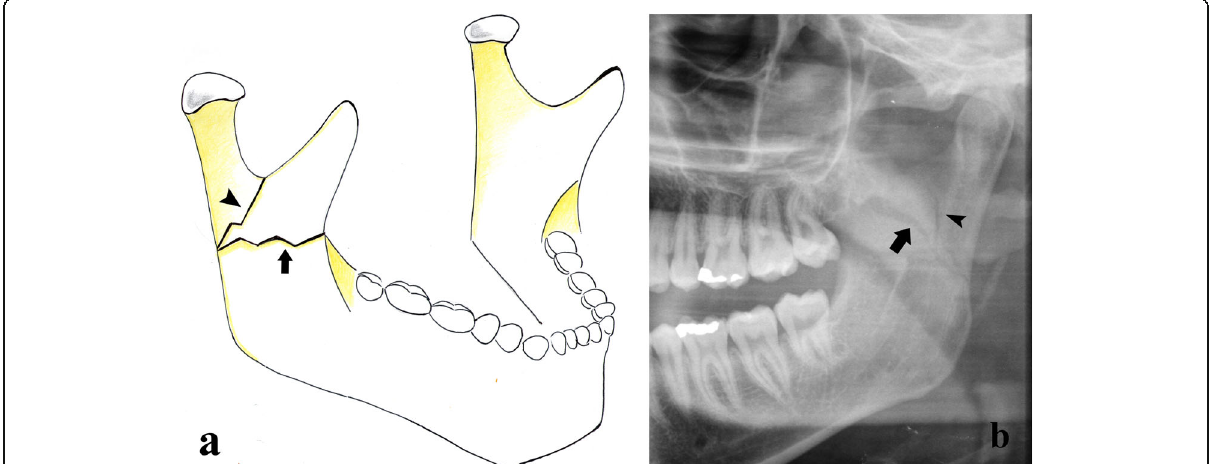
Fig. 6 Ramus fractures. a Picture showing that the mandibular ramus fracture can be vertical (arrowhead) or horizontal (arrow), depending on the direction of the fracture rhyme. b Cropped panoramic radiograph. Combined fracture of the left mandibular ramus. The fracture rhyme originates from the external face of the ramus and has both a vertical (arrowhead) and a horizontal (arrow) course